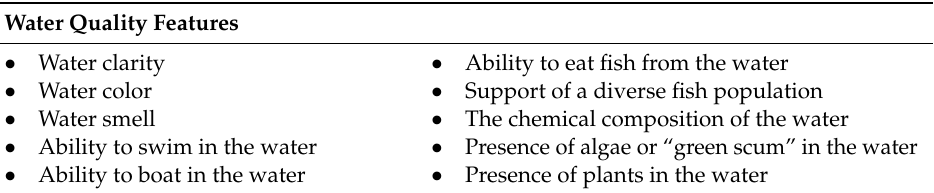
Table 2. Water quality